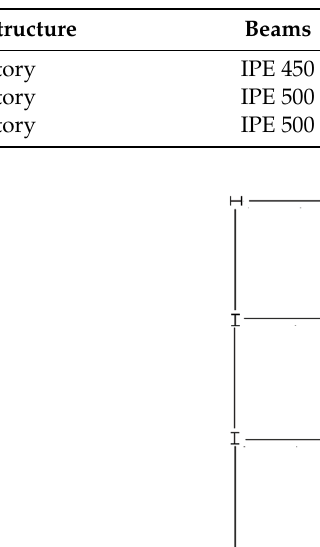
Table 1. Sections of steel beams, braces, and columns.